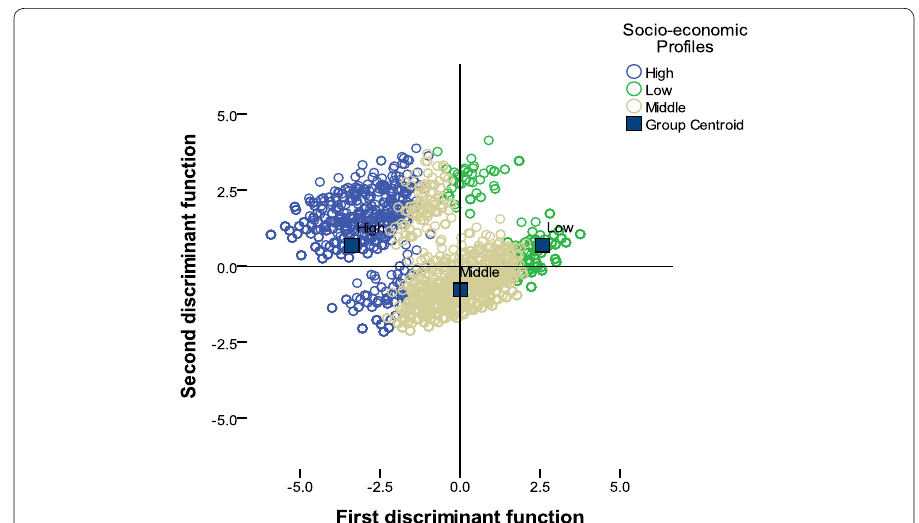
Fig. 2 Centroids of the three socio‑economic profiles on the two discriminant functions derived from the data